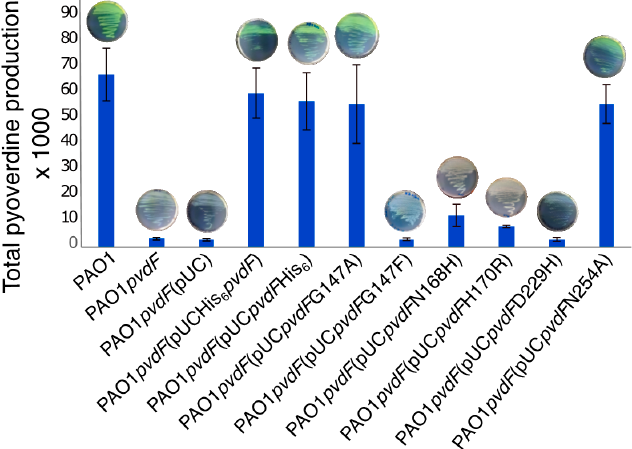
Figure 6. Pyoverdine production in P. aeruginosa pvdF containing PvdF variants. Pyoverdine production in broth culture was measured for the P. aeruginosa pvdF mutant containing plasmid-borne pvdF variants. The mean of three biological replicates along with standard error bars are shown. Agar plates, with pyoverdine giving green pigmentation, are shown above each bar.